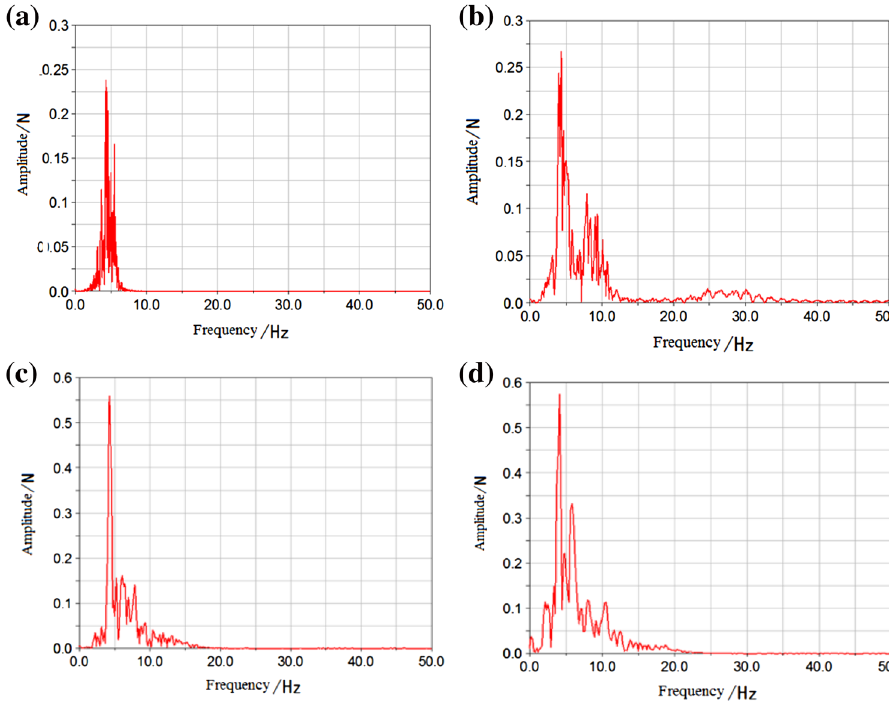
Fig. 7 Frequency spectrum of contact force in straight track. a Speed 20 km/h right pantograph. b Speed 40 km/h right pantograph. c Speed 60 km/h right pantograph. d Speed 80 km/h right